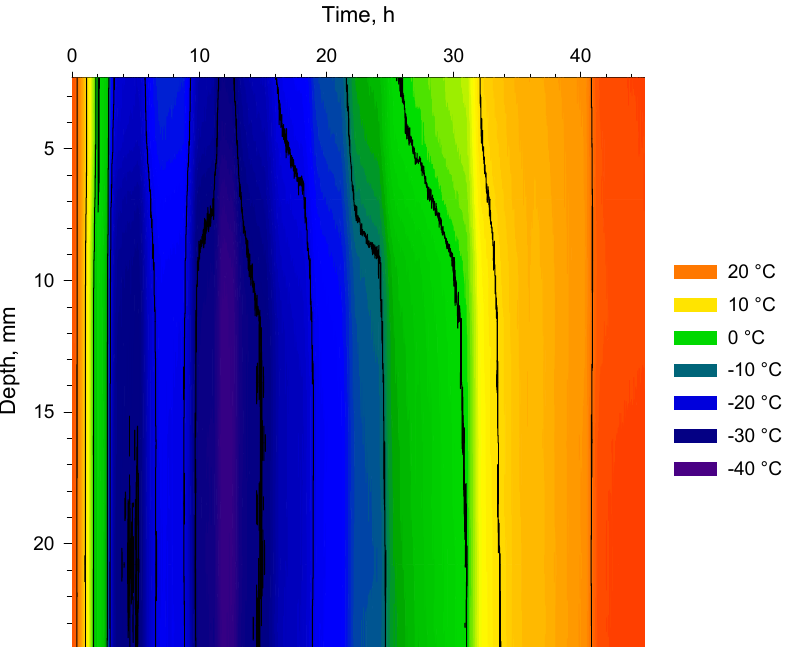
Figure 6. Full time/temperature profile from 0 to 45 h based on 2700 thermograms of Ge ‐ cuvette along depth profile shown in Figure 4b. The main events of the freeze-drying cycle are visible: freezing, annealing, sublimation, and secondary drying. Black lines are 10 ◦ C increments between − 30 to +20 ◦ C. Ambient pressure 0–11 h, 0.05 mbar 11–36 h, and 3 µ bar 36–45 h. All temperature measurements were corrected with an emissivity of 0.9.